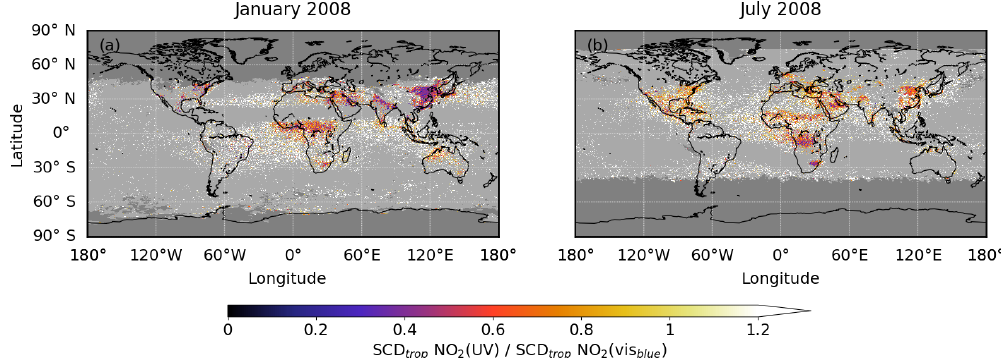
Figure 9. Ratio between monthly mean tropospheric SCDs of NO 2 in the UV and blue spectral range. (a) January 2008 and (b) July 2008. Dark grey shaded area: no NO 2 values available. Light-grey-coloured values indicate values where the vis blue NO 2 is close to zero, which have been filtered out (Fig.